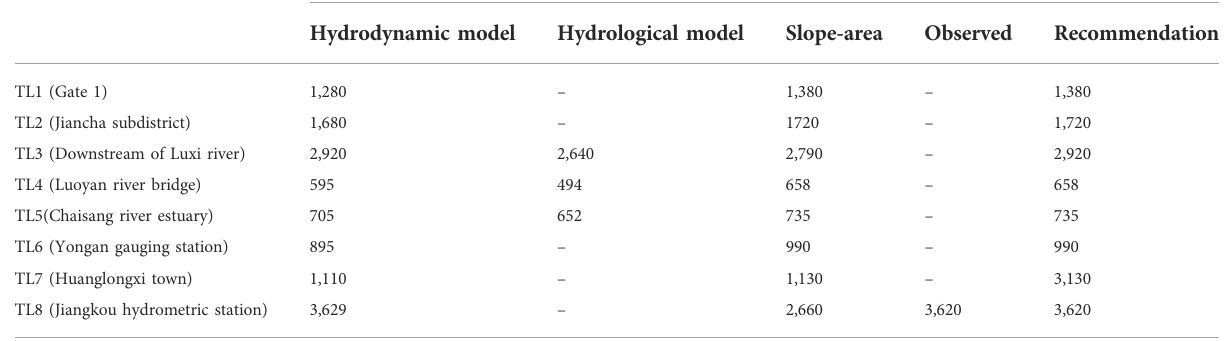
TABLE 7 Comparison and recommendation of peak discharge results.